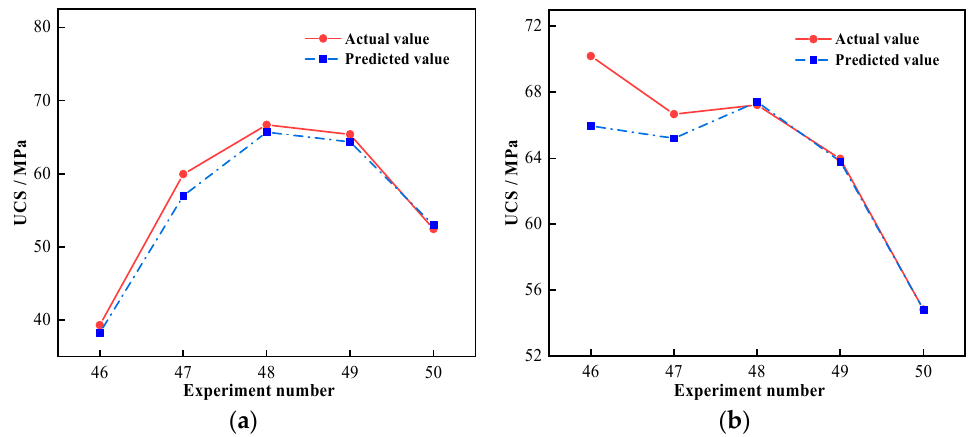
Figure 9. Comparison of prediction results of BP neural network: ( a ) Sample A; ( b ) Sample M. The R 2 of the BP neural network’s prediction results was calculated as 0.99 and 0.91, respectively. The R 2 and goodness-of-fit of the BP neural network model decreased as compared to the SVR model (Table 10). It is worth noting that the prediction accuracy of the individual tests (Nos. 46 and 47) in Figure 9b significantly decreased, and the maximum